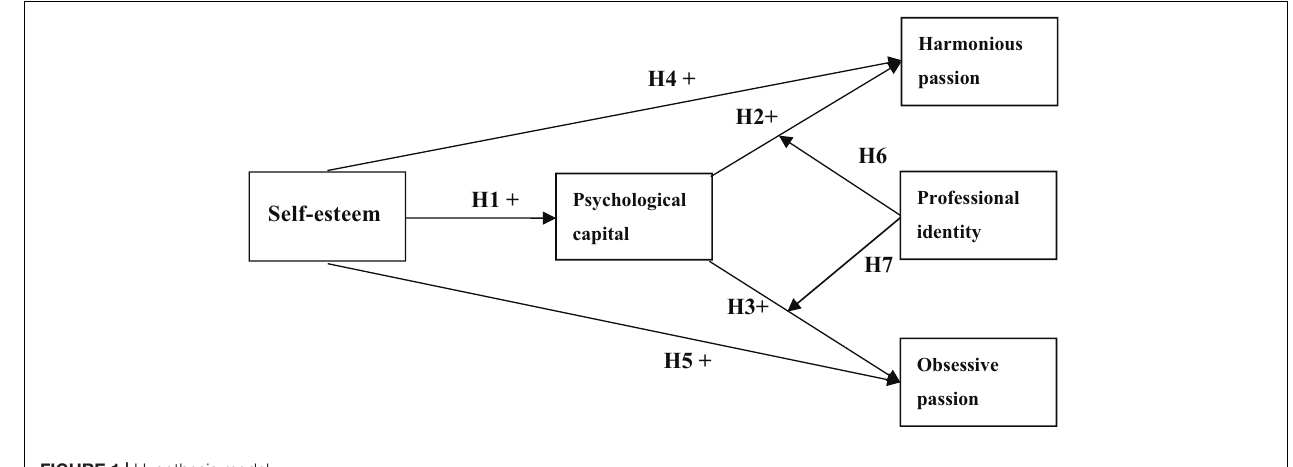
FIGURE 1 | Hypothesis